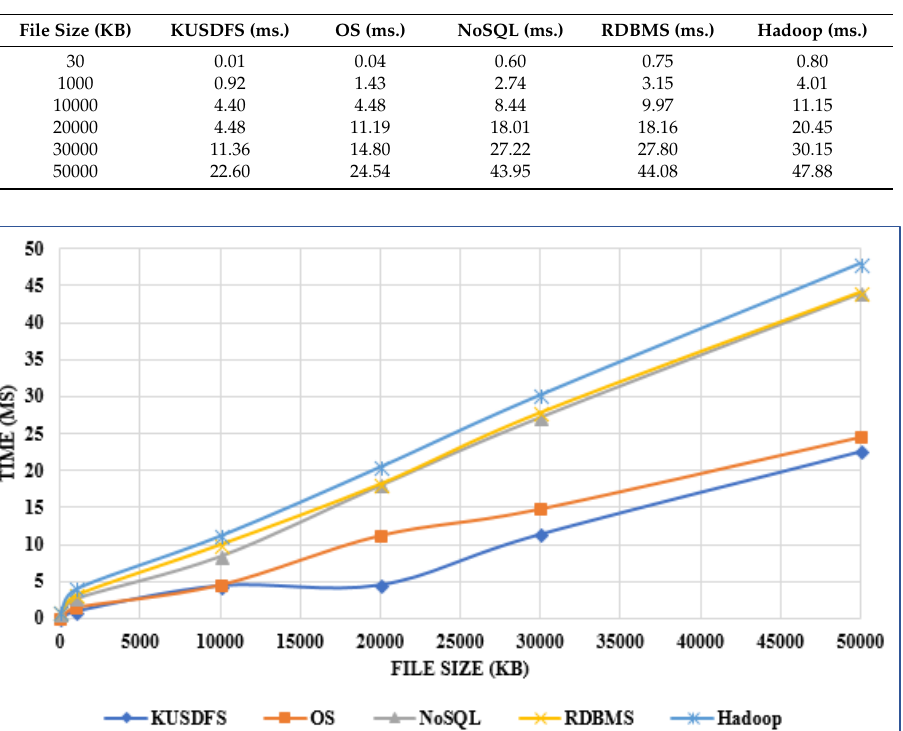
Table 2. The response times given by the systems for different file size (ms.)